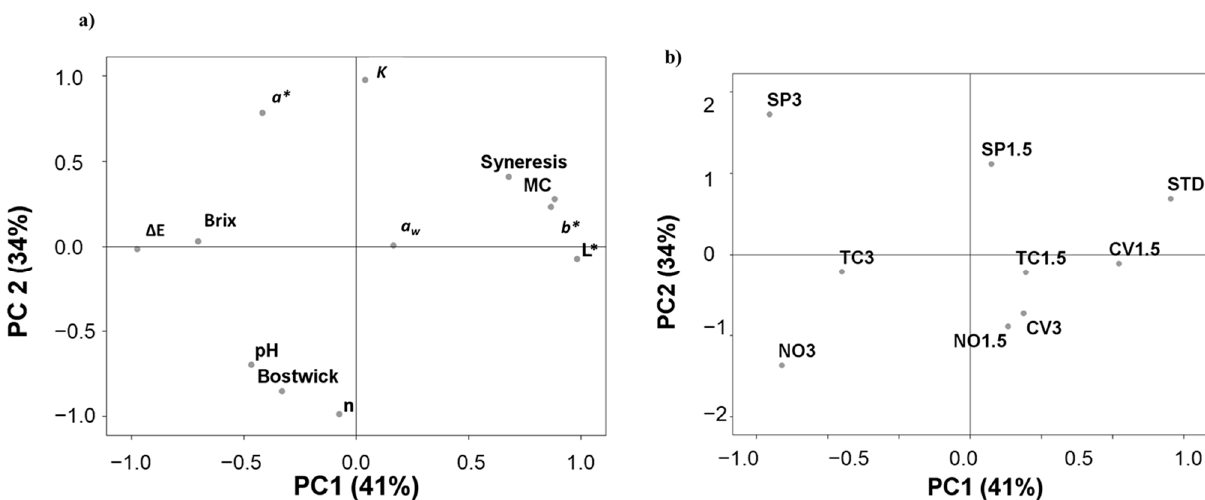
Figure 3. Scattering the data of physicochemical and rheological properties by the first two principal components (PC1 and PC2) derived from principal component analysis (PCA) of vegetable creams reformulated using different strains at different levels of addition. ( a ) Biplot of the first two components; ( b ) rotated principal scores of reformulated vegetable creams projected into the first two principal components. STD: standard; SP: Spirulina ( Arthrospira platensis ); CV: Chlorella vulgaris ; TC: Tetraselmis chui ; NO: Nannochloropsis oceanica .